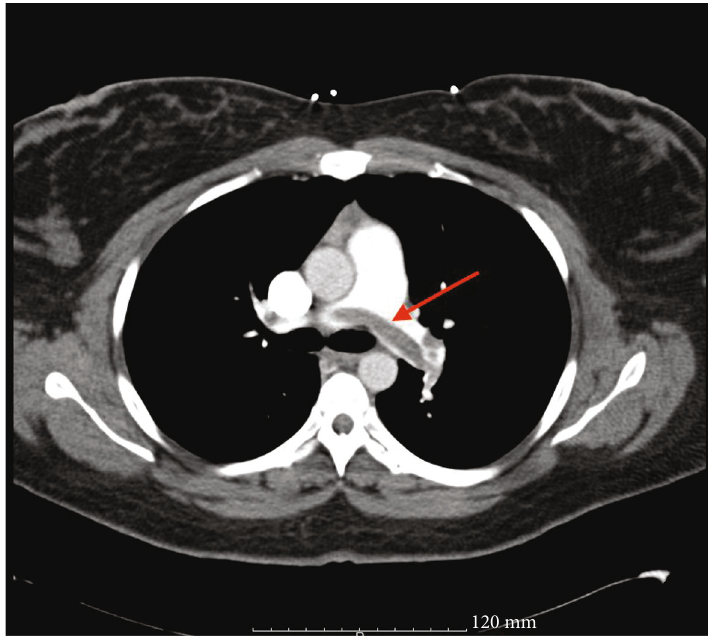
Figure 2: Computed tomography of the chest, transverse view, demonstrated a large saddle embolus as indicated by the red arrow.